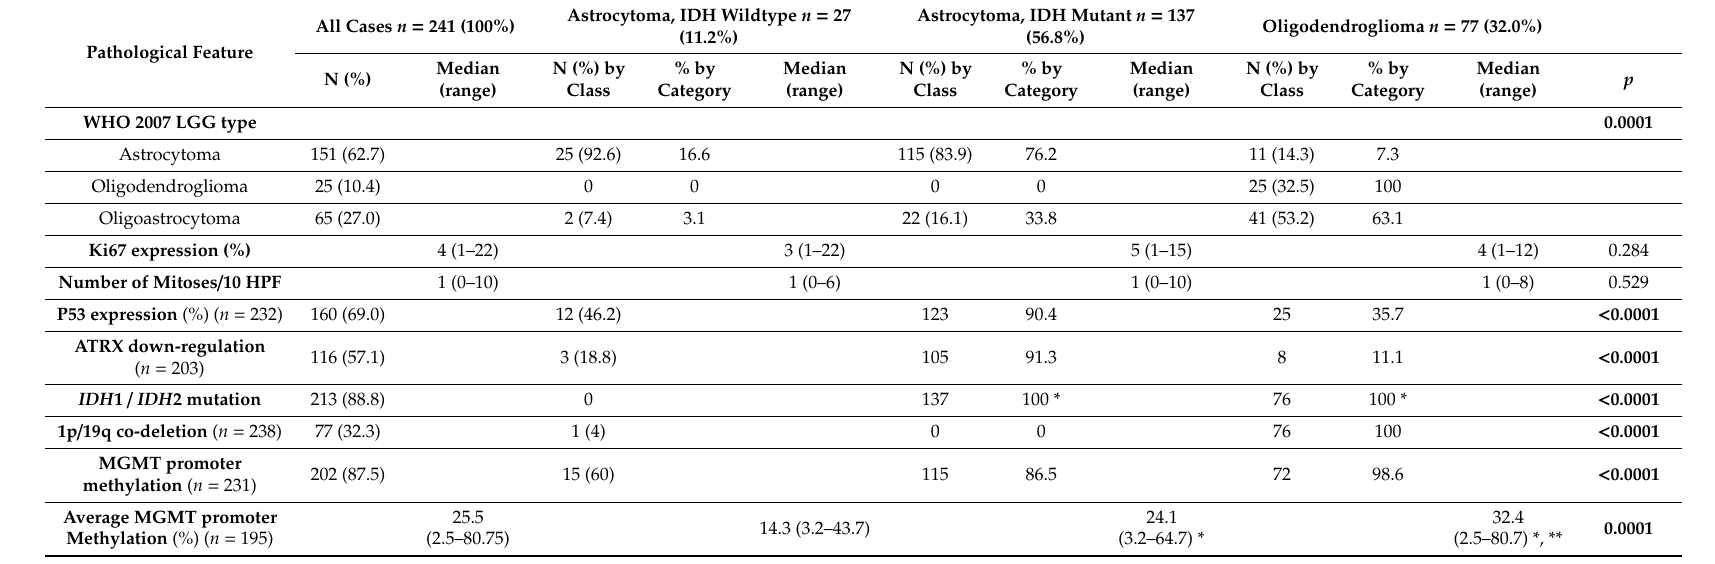
Table 2. Pathological and molecular features of the 241 symptomatic LGG patients included in the study. For the feature, WHO 2007 LGG type are reported in the %, within the molecular class, of the di ff erent WHO 2007 types as well as the percentage of cases pertaining to each molecular class within each WHO 2007 type. *, ** p < 0.05 vs. astrocytoma, IDH wildtype and astrocytoma, IDH mutant, respectively. Boldfacing represents statistical significance ( p < 0.05) from Dunn’s